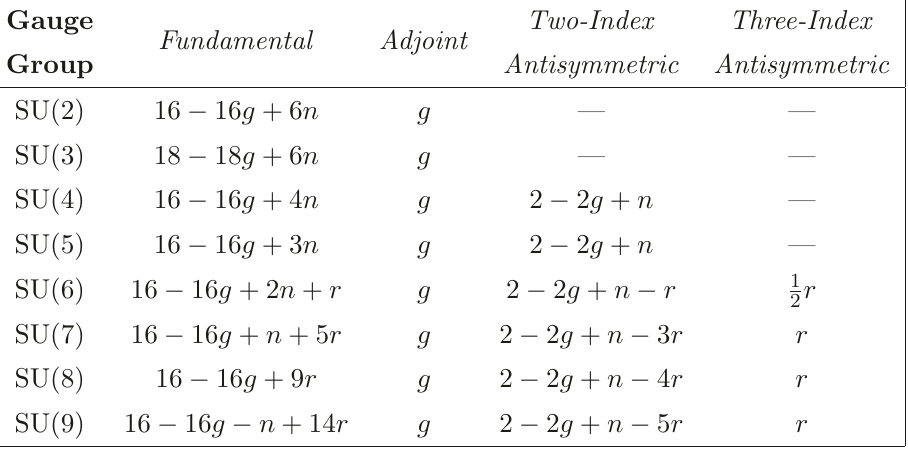
Table 2 . Charged matter multiplicities for SU( N ) gauge groups. The multiplicities are given in terms of the arithmetic genus g and the self-intersection n = b · b of the SU( N ) divisor. Entries with a dash indicate representations that are not relevant for the gauge group in question. Note that r is a free